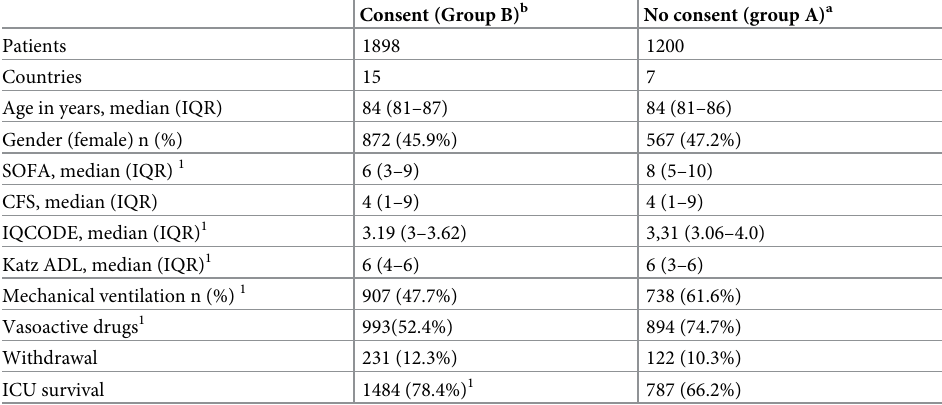
Table 1. Demographic and clinical data in all patients. Data given as median and